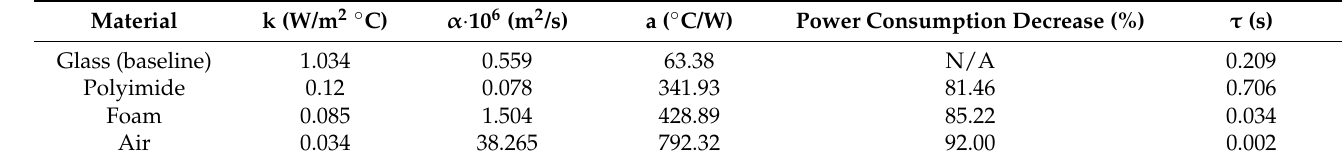
Table 3. Material properties and results from the substrate material design